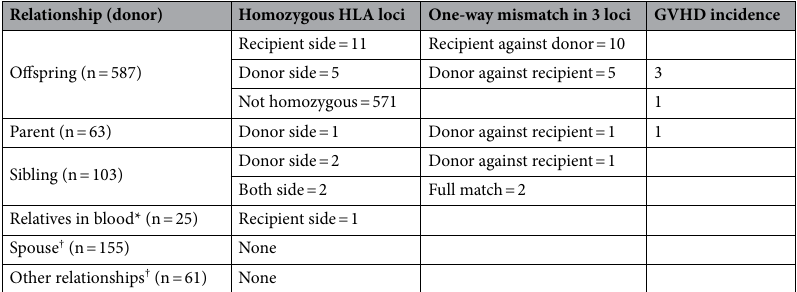
Table 3. Number of homozygous HLA loci according to relationship between donor and recipient in LDLT. *Relatives who are not parent, offspring, or sibling. † Genetically unrelated